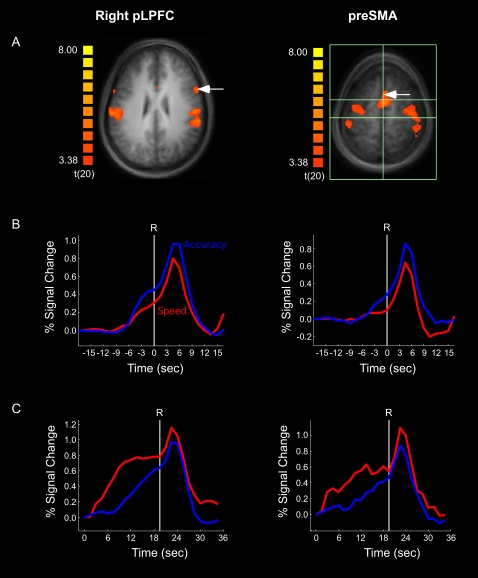
fMRI results for pLPFC (left column) and the average of left and right pre-SMA (right column): (a) Location of right pLPFC (white arrow) and pre-SMA (white arrow) in the localizer task.The anterior and posterior horizontal bars in the pre-SMA figure indicate the coronal planes of the anterior and posterior commissures. (b) Speed and accuracy time courses for the coherence trials, time-locked to the onset of the response (R) and normalized to the onset of stimulus coherence. (c) Speed and accuracy time courses for the baseline trials, time-locked and normalized to the onset of the trial.